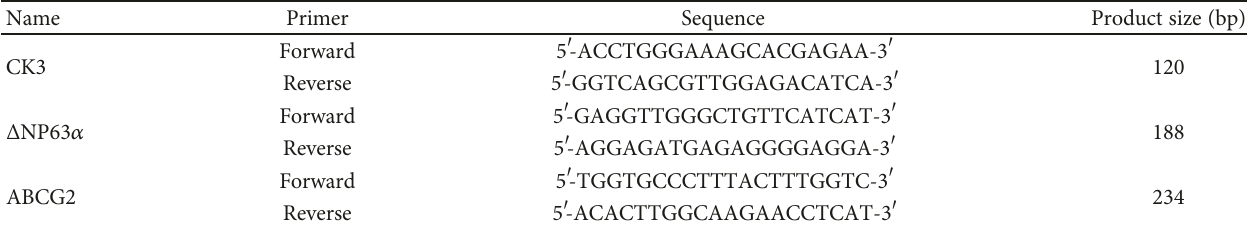
Table 1: Parameters for RT-PCR analysis of di ff erent genes in